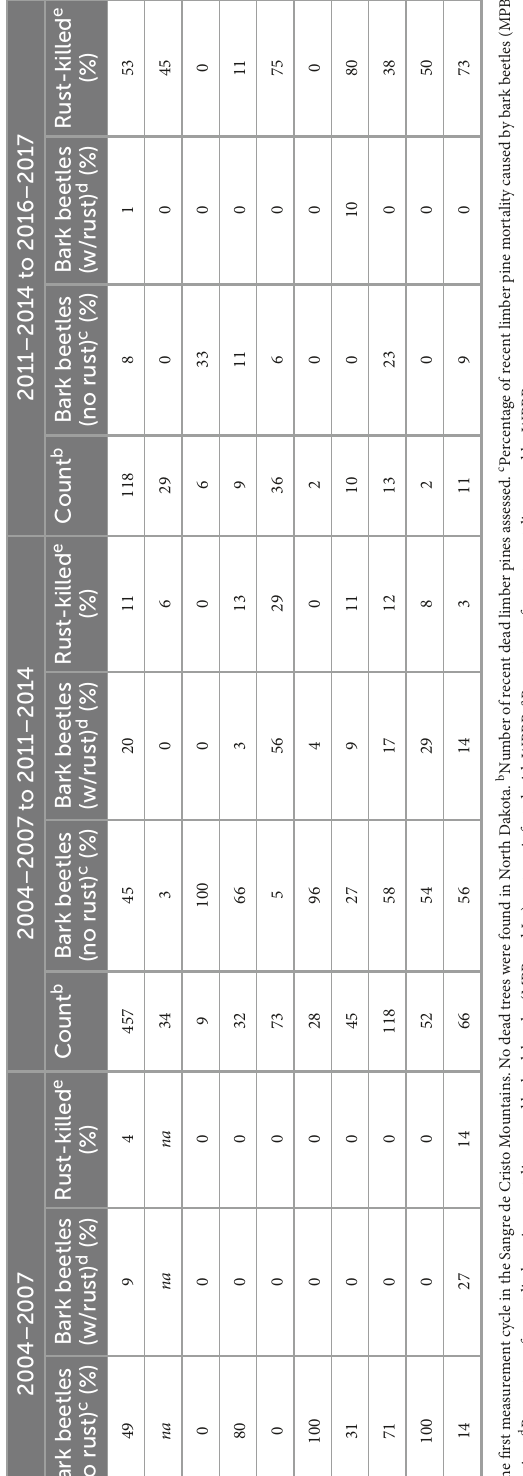
Density of live limber pine greater than 1.37 m tall in the small ( < 12.7 cm dbh) and medium (12.7–30.5 cm dbh) diameter classes decreased significantly while density in the large ( > 30.5 cm dbh) diameter class remained stable over the course of the study ( Supplementary Table 5a ). The annualized mortality rate for limber pine was about 4%/year overall and ranged from < 1%/year in the Sangre de Cristo Mountains to 8%/year in Montana ( Figure 2 ). Ingrowth recruitment rates were lower than mortality rates overall ( ∼ 1.25%) and in every study area. Ingrowth recruitment rates also had a narrower range than mortality rates from the lowest on Pole Mountain at < 1% to the greatest on the Shoshone NF at ∼